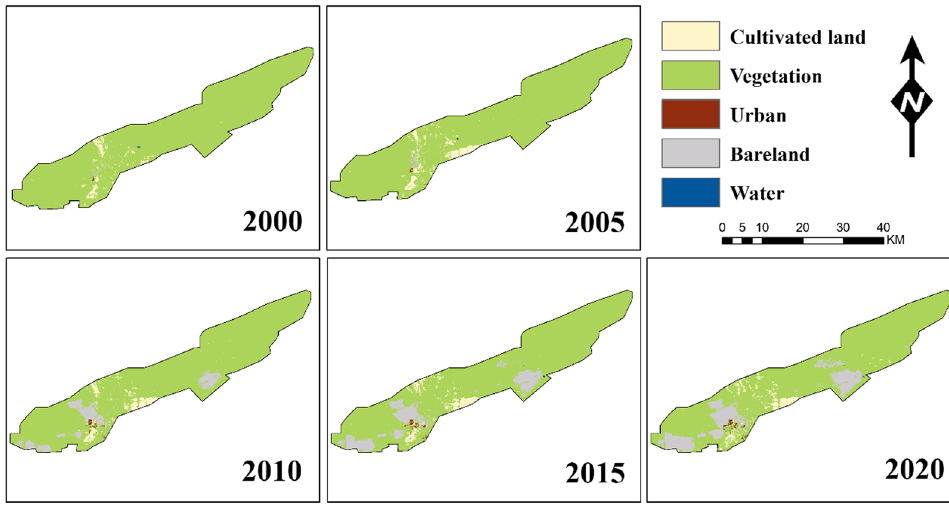
Fig. 2 Mining area distribution of land use in different periods in the Shengli